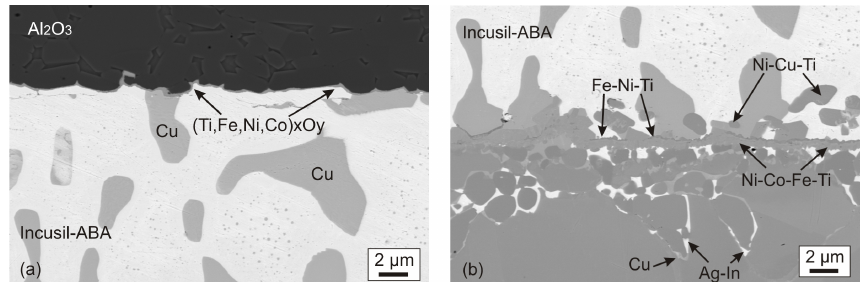
Figure 6. Enlarged SEM images of Fig. 5a showing the Al 2 O 3 /Incusil-ABA (a) and the Kovar/Incusil-12.5-ABA interfaces (b) .